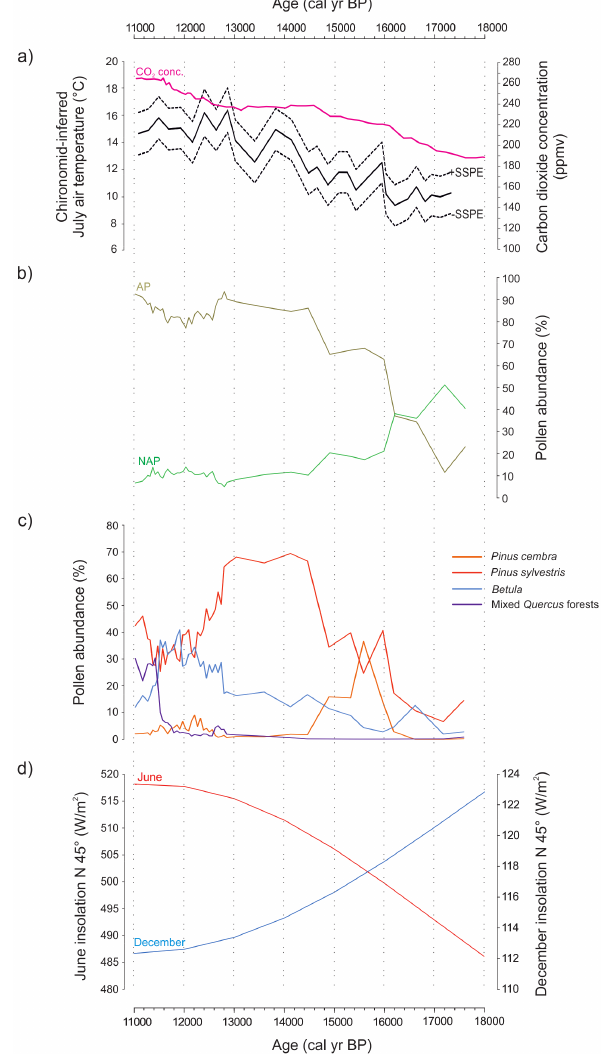
Fig. 6. (a) Chironomid-inferred July air temperature estimates in- cluding sample specific error of prediction (SSPE) compared with carbon dioxide concentration data from the European Project of Ice Coring in Antarctica (EPICA) (Lourantou et al., 2010); (b) pollen percentages of arboreal (AP) and non-arboreal pollen (NAP), and (c) of Pinus sylvestris , Pinus cembra , Betula , and mixed Quercus forests ( Quercus , Ulmus , Tilia ) of the Origlio sediment core (Tinner et al., 1999); (d) mean winter (December-February) and mean sum- mer (June–August) insolation values at 45 ◦ N (Berger and Loutre,